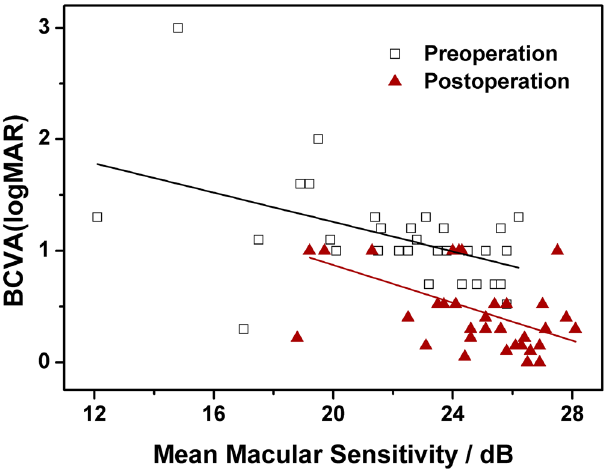
Figure 1. Association between the best-corrected visual acuity (BCVA) with mean macular sensitivity (MMS) before and after surgery. The “ □ ” symbols represent preoperative visual acuity and MMS data, and the red “ ▲ ” symbols show the postoperative visual acuity and MMS data. The solid lines represent the linear regression curves for the data obtained before and after